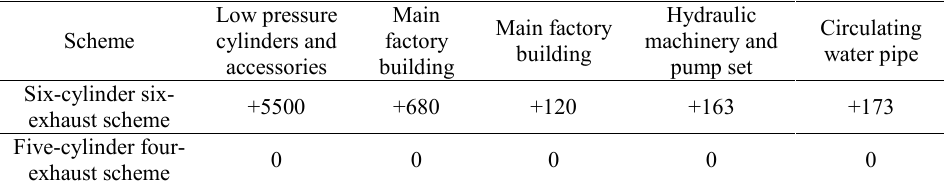
Table 4. Investment comparison of two design schemes.